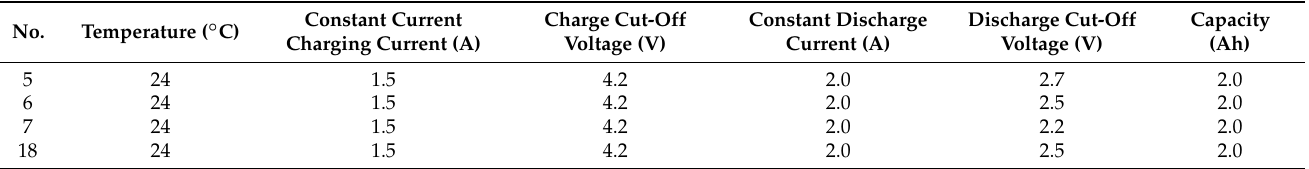
Table 1. Experimental conditions for the battery